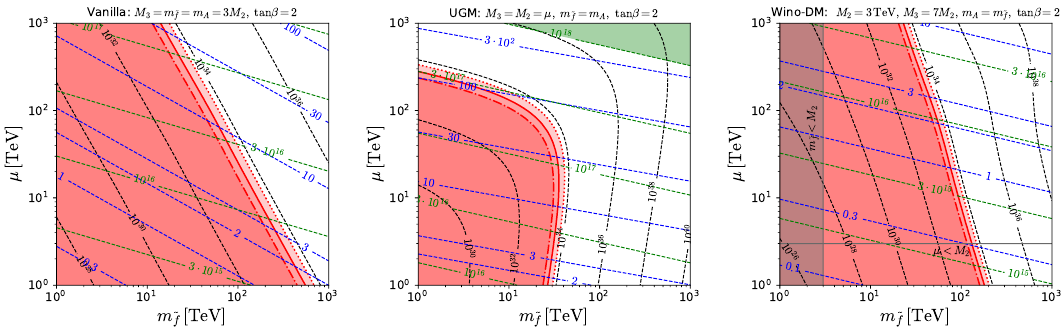
Figure 1 . The low energy SUSY parameter space ( m ~ f versus (cid:22) plane) for three di(cid:11)erent scenarios: Left ; \vanilla" SUSY with M Centre ; UGM scenario 3 = 3 M 2 = m A = m ~ f and tan (cid:12) = 2. with M 3 = M 2 = (cid:22); m A = m ~ and tan (cid:12) = 2. Right ; Wino DM scenario with M 2 = 3 TeV, f M 3 = 7 M 2 , m A = m ~ and tan (cid:12) = 2. The light red region is excluded due to the current limit, f (cid:28) ( p K + (cid:22) (cid:23) ) > 4 : 0 10 33 yrs. The band around the boundary of the red region represents the ! (cid:1) uncertainty coming from (cid:11) s ( m Z ). The dashed-dotted and dotted contours correspond to the limit obtained from (cid:11) s ( m Z ) = (cid:11) 0 (cid:1) (cid:11) s , respectively. The dashed black, green and blue contours s (cid:6) represent the values of (cid:28) ( p K + (cid:22) (cid:23) )/yrs, M H /GeV and T S /TeV, respectively. The shaded green C ! region is disfavoured because M H is close to the Planck C